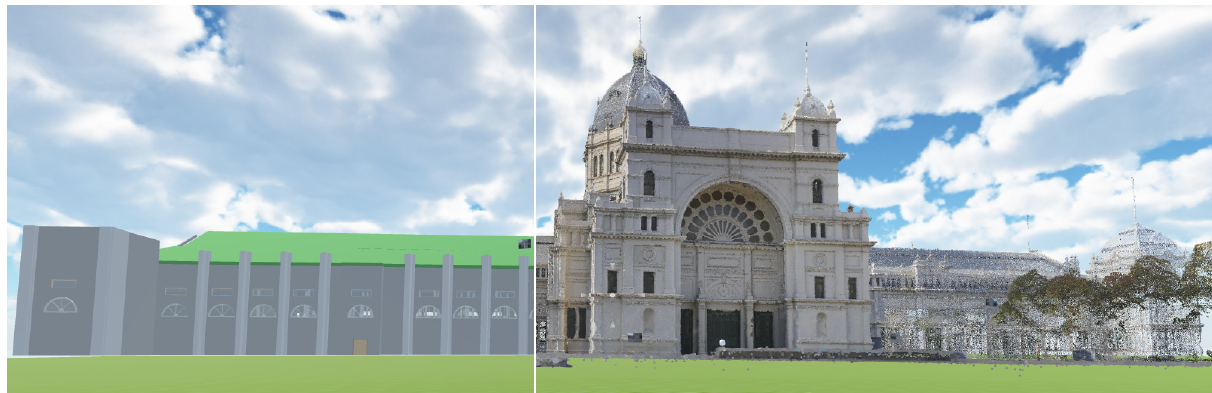
Figure 1. The multilayered model of the Royal Exhibition Building in Melbourne. The figure merges two screenshots made in the developed platform, parametric model on the left and polygonal mesh and point cloud on the